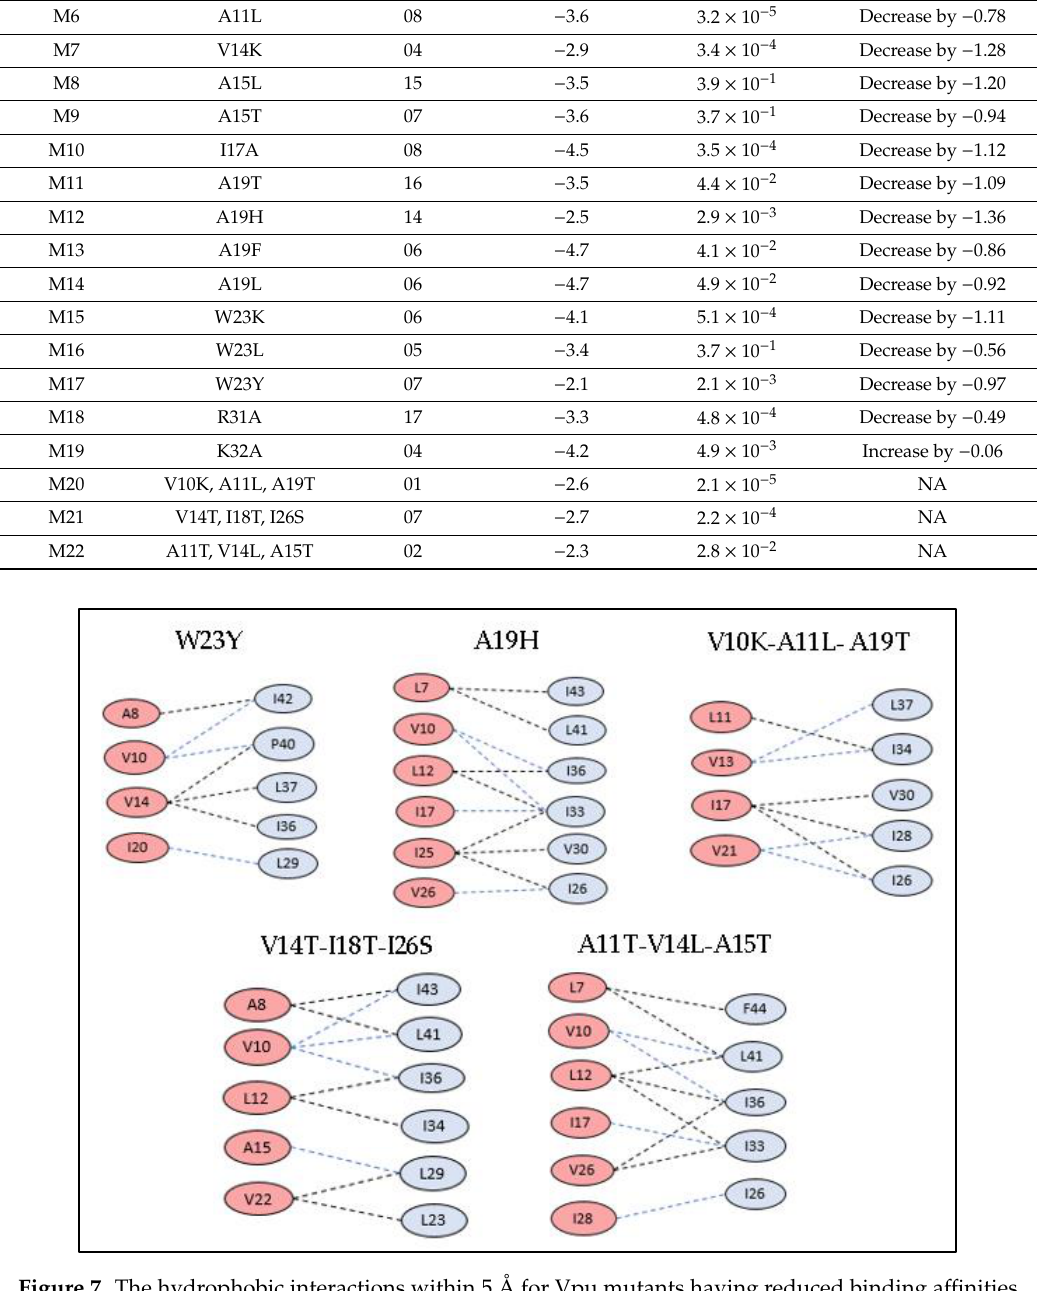
Table 7. Aggregating regions predicted in tetherin by seven servers. Consensus results are highlighted as regions predicted by at least six of the seven servers.